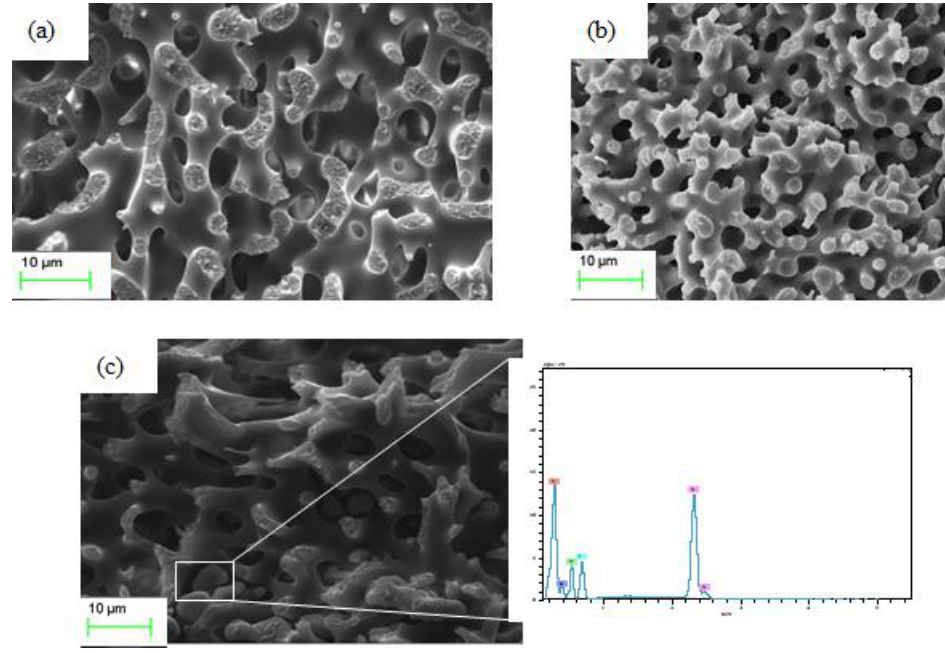
Figure 6. Cross-section SEM images of cryo-fractured membranes: ( a ) Matrimid ® film, ( b ) Matrimid ® / BIM-TFSI, ( c ) Matrimid ® / MIM-TFSI. Inset: EDX